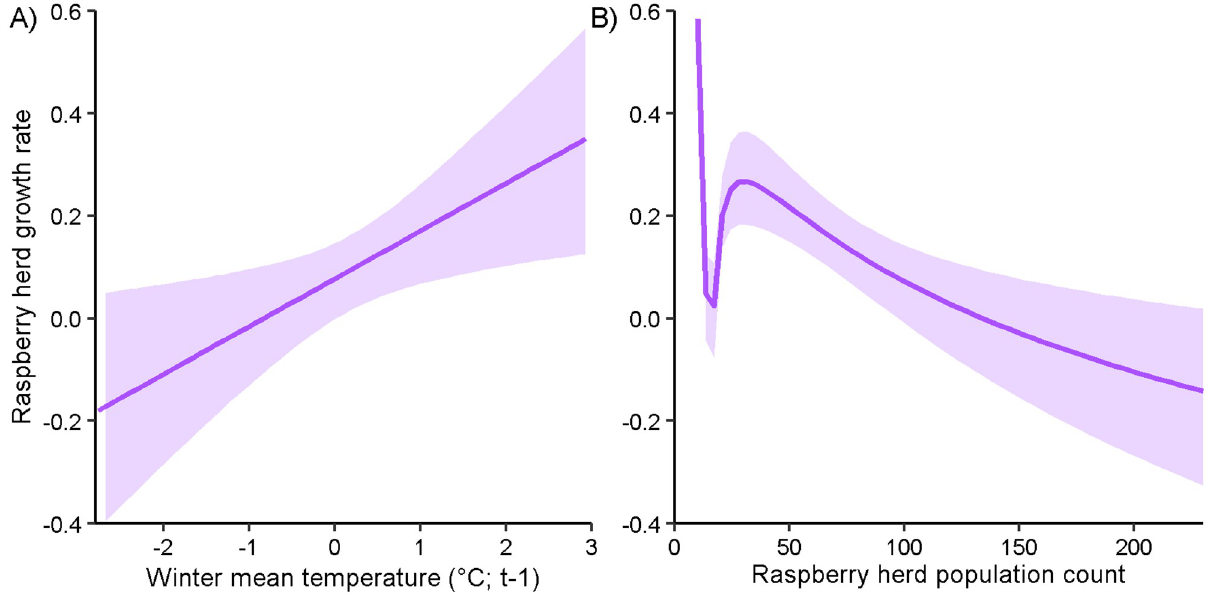
Fig 5. Elk Raspberry herd growth rate predicted by mean winter temperature and population count. Model-predicted response of semi-annual Raspberry herd abundance as a function of (A) mean winter temperature in the previous year and (B) elk population count, with 95% credible intervals (shading), Raspberry Island, Alaska, USA,